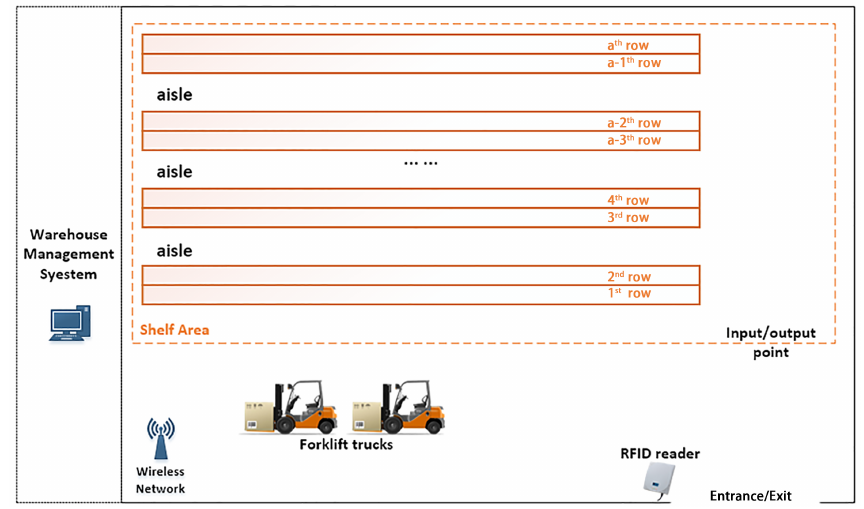
Figure 5. Layout of intelligence